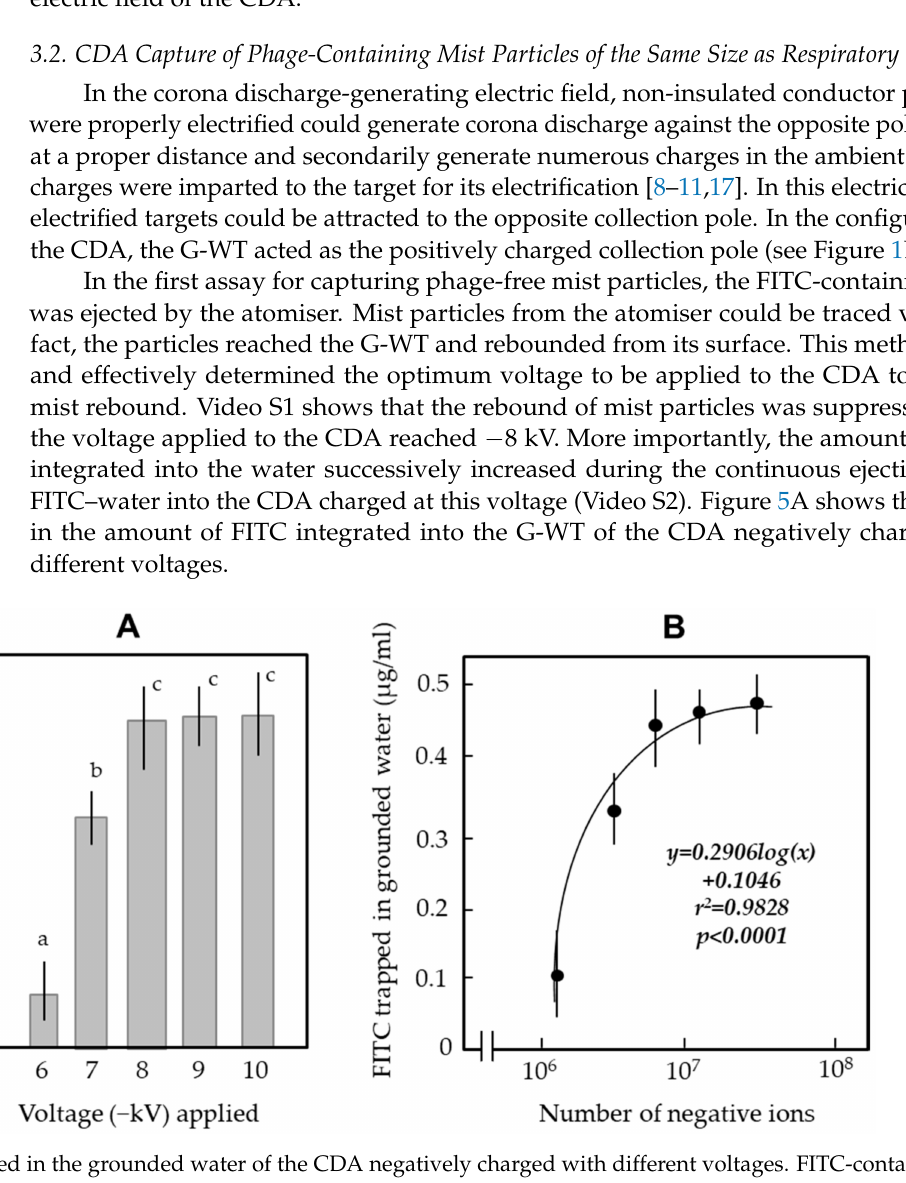
Figure 5. ( A ) FITC trapped in the grounded water of the CDA negatively charged with different voltages. FITC-containing mist was ejected for 30 s. The means and standard deviations were calculated from five repetitions of the experiments. The letters (a–c) on each column indicate significant differences ( p < 0.05) according to Tukey’s method. ( B ) Positive correlation between trapping of FITC and negative ion generation in the electric field of the